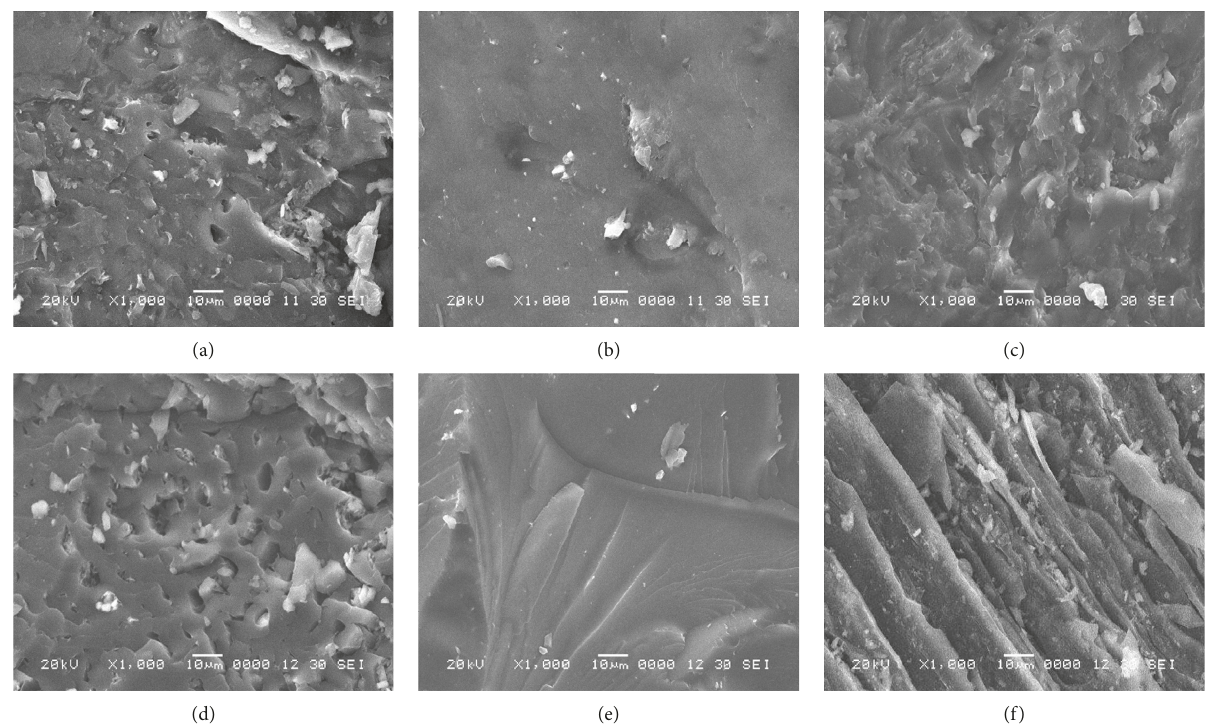
Figure 2: Raw coal sample SEM images ( × 1000). (a) B-1 coal sample. (b) B-2 coal sample. (c) B-3 coal sample. (d) B-4 coal. (e) B-5 coal sample. (f) B-6 coal